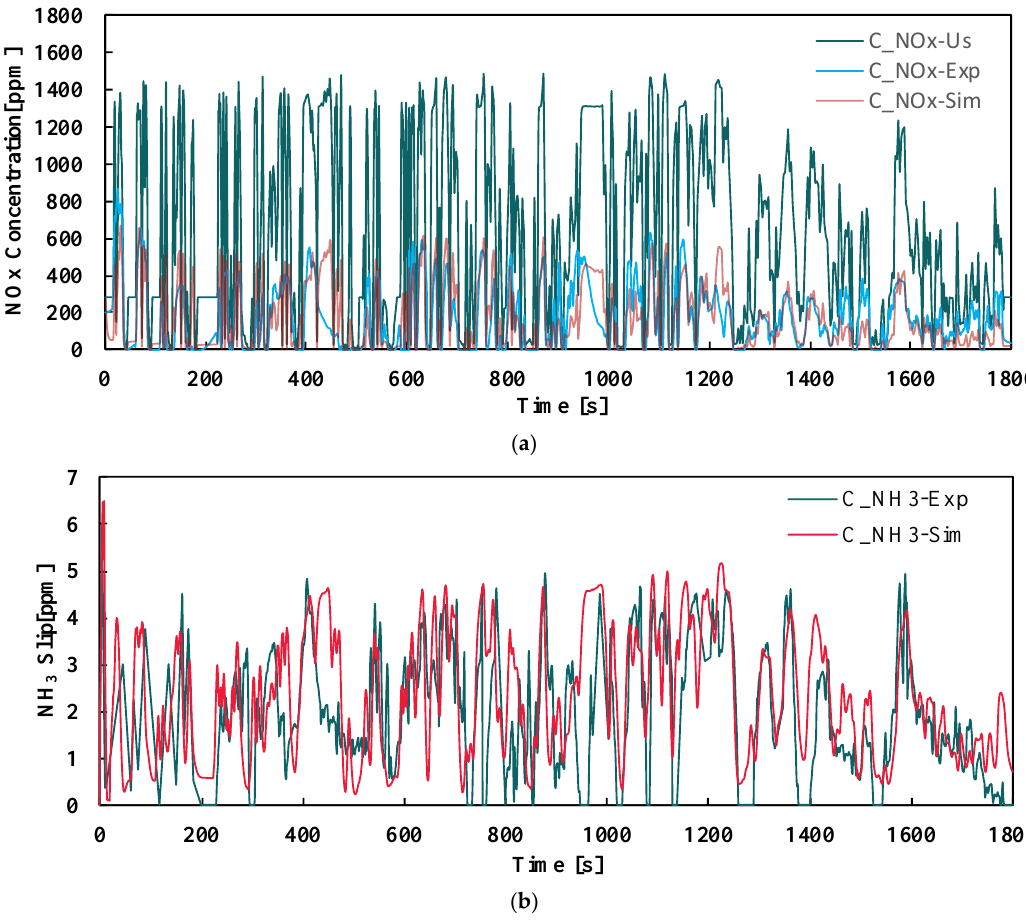
Figure 4. Comparison of simulation and experiment results. ( a ) NO x concentration; and ( b ) NH 3 slip.